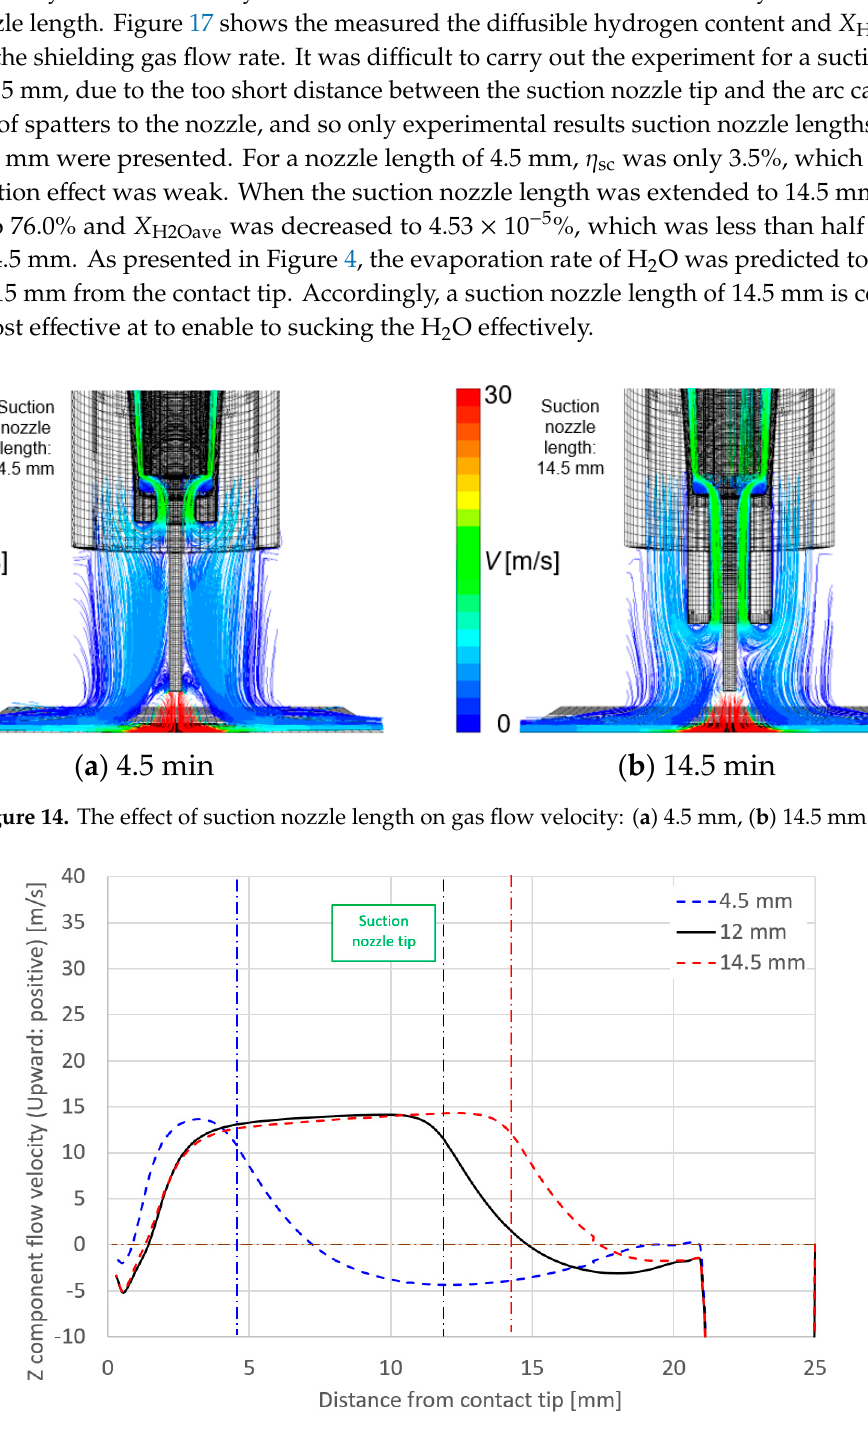
Figure 15. Axial distribution of Z component flow velocity as a function of suction nozzle length.